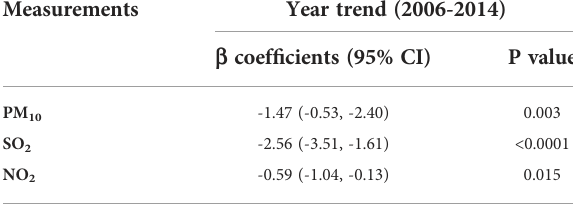
TABLE 2 The integrated year trend of PM 10 , SO 2 and NO 2 in seven Chinese